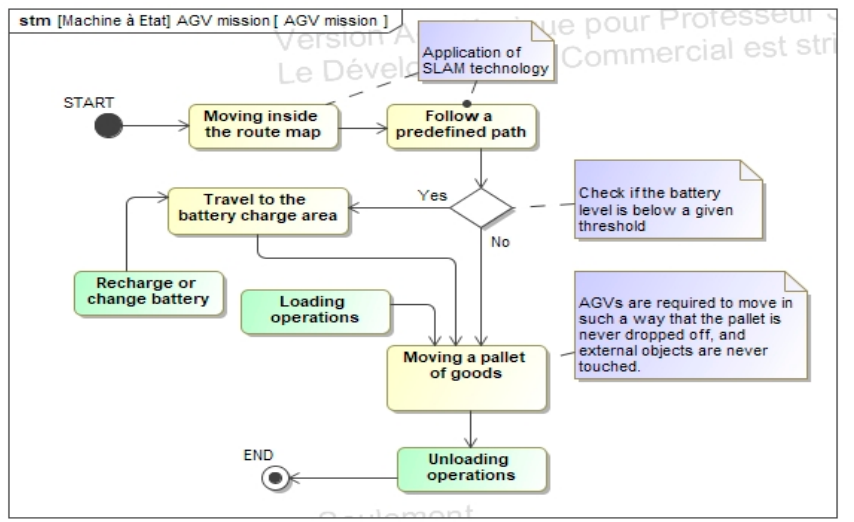
Figure 12. AGV missions in SysML.